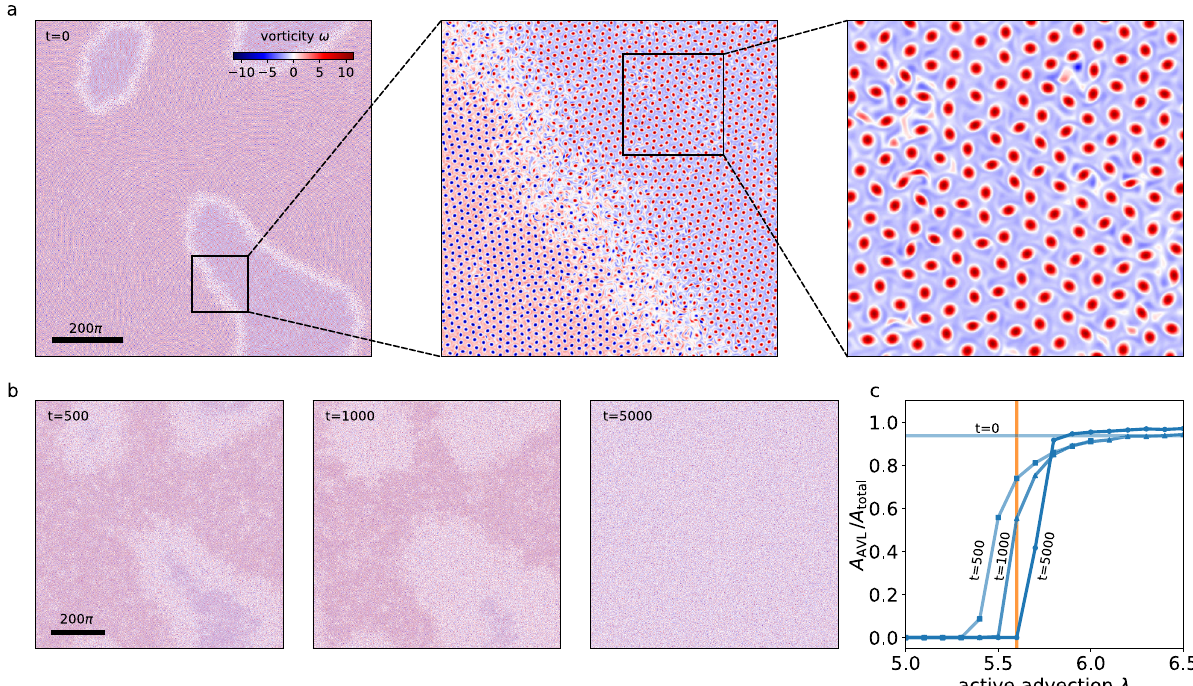
Fig. 5 Melting of active vortex lattice domains. ( a ) Transient meta-stable opposite-polarity AVL domains ( λ = 7, α = − 0.8, domain size L = 1000 π ). The zoom-in shows that these domains are demarcated by an interfacial layer of active turbulence. Panel ( b ) illustrates the melting of the AVL domains shown in panel ( a ) for λ = 5.6 after times t = 500, t = 1000 and t = 5000. ( c ) Area fraction of the domains as a function of active advection for times t = 500 (squares), t = 1000 (triangles) and t = 5000 (circles), starting from the con fi guration ( a ) at time t = 0. Note that the transient width of the domain boundaries is controlled by the strength of the active advection. The orange line corresponds to the snapshots shown in panel ( b